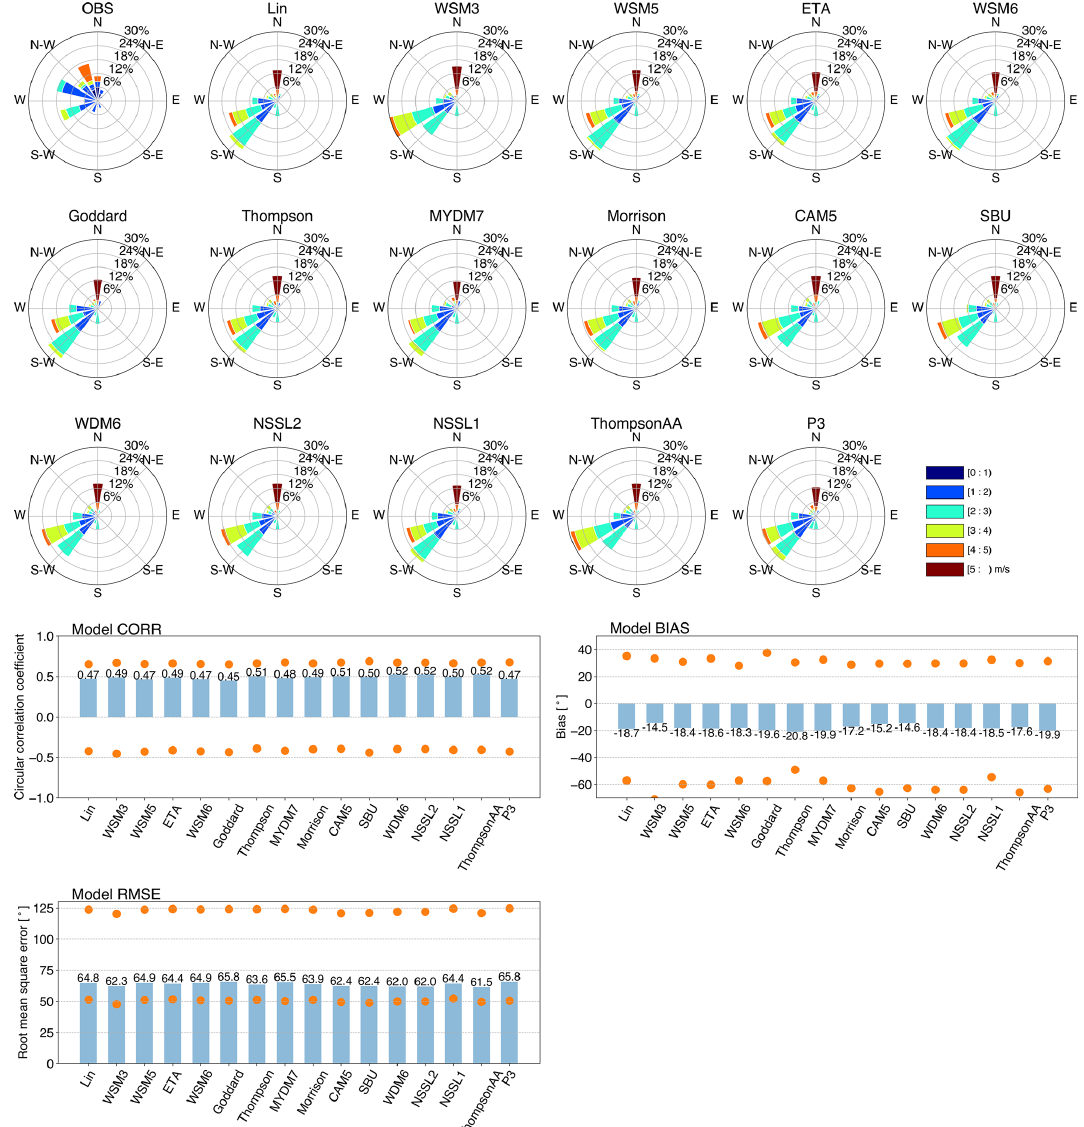
Figure 6. Same as Fig. 4, but for the MP